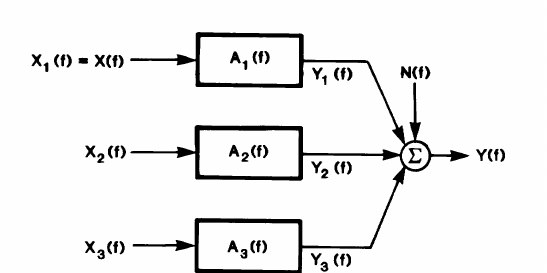
FIGURE 6 Three-input/single-output linear model equivalent to Fig. 5 where the inputs can be corre lated.